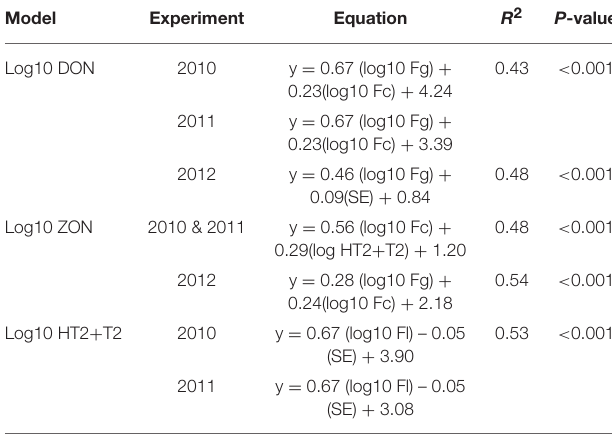
TABLE 6 | Multiple linear regression of physiological traits and Fusarium spp. DNA (pg ng − 1 of Total DNA) in grain on Area Under the Disease Progress Curve (AUDPC) of wheat genotypes in field experiments 2010, 2011, & 2012 and 2011 & 2012 glasshouse experiments.